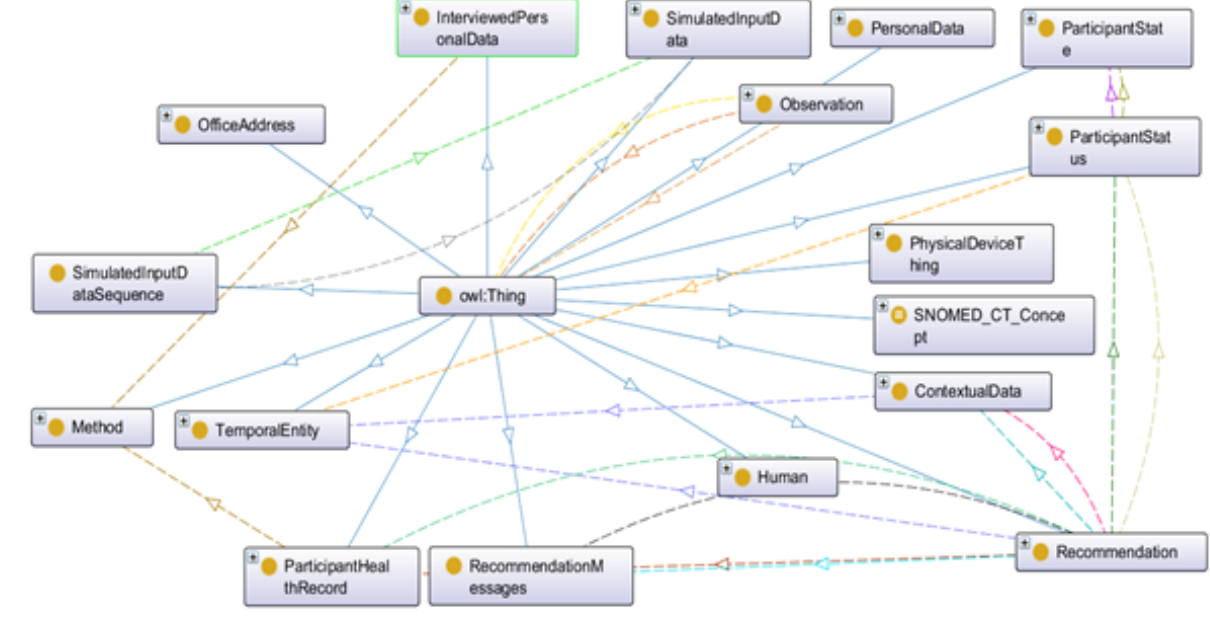
Figure 10. Proposed eHealth Ontology implementation in Protégé